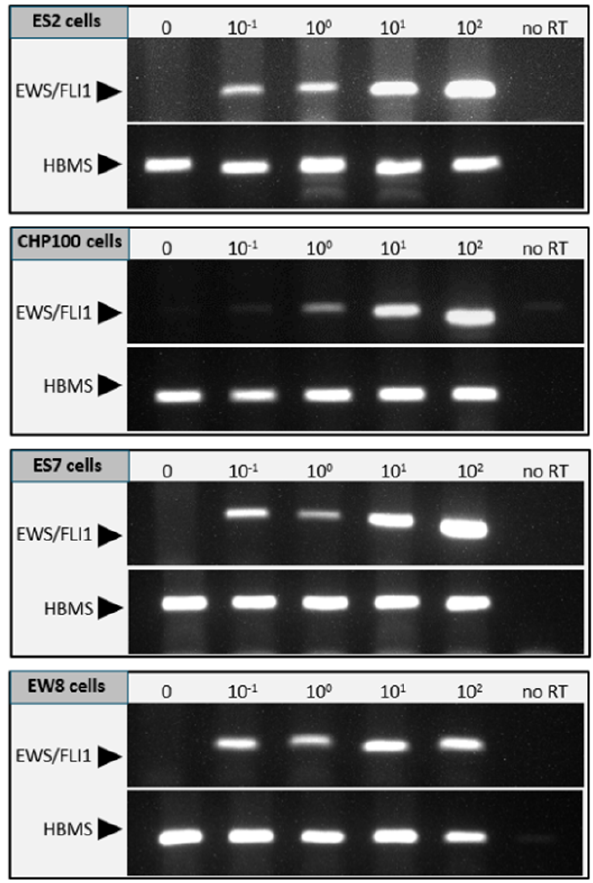
Figure 4. Determining the sensitivity of the RT-PCR for the detection of the tumor specific EWS-FLI1 fusion transcript. The lower limit of detecting ES tumor cells in the context of ovarian cortex tissue was determined by spiking tissue fragments with a set number of cells (0, 0.1, 1, 10 or 100 cells) from cell lines ES2, CHP-100, ES7 or EW8. After RNA isolation and reverse transcription, the first strand cDNA was used for PCR to detect the EWS-FLI1 fusion transcript. Agarose gel electrophoresis of PCR products showed that the lower limit of detection for CHP-100 was 1 cell, for ES2, ES7 and EW8 it was less than 1 cell. In RNA from ovarian tissue without ES cells or with spiked EWS cells but without a reverse transcription reaction (no RT), the EWS-FLI1 fusion transcript was not detected by PCR. Expression of the housekeeping gene hydroxymethylbilane (HBMS) was used to normalize EWS-FLI1 signals.